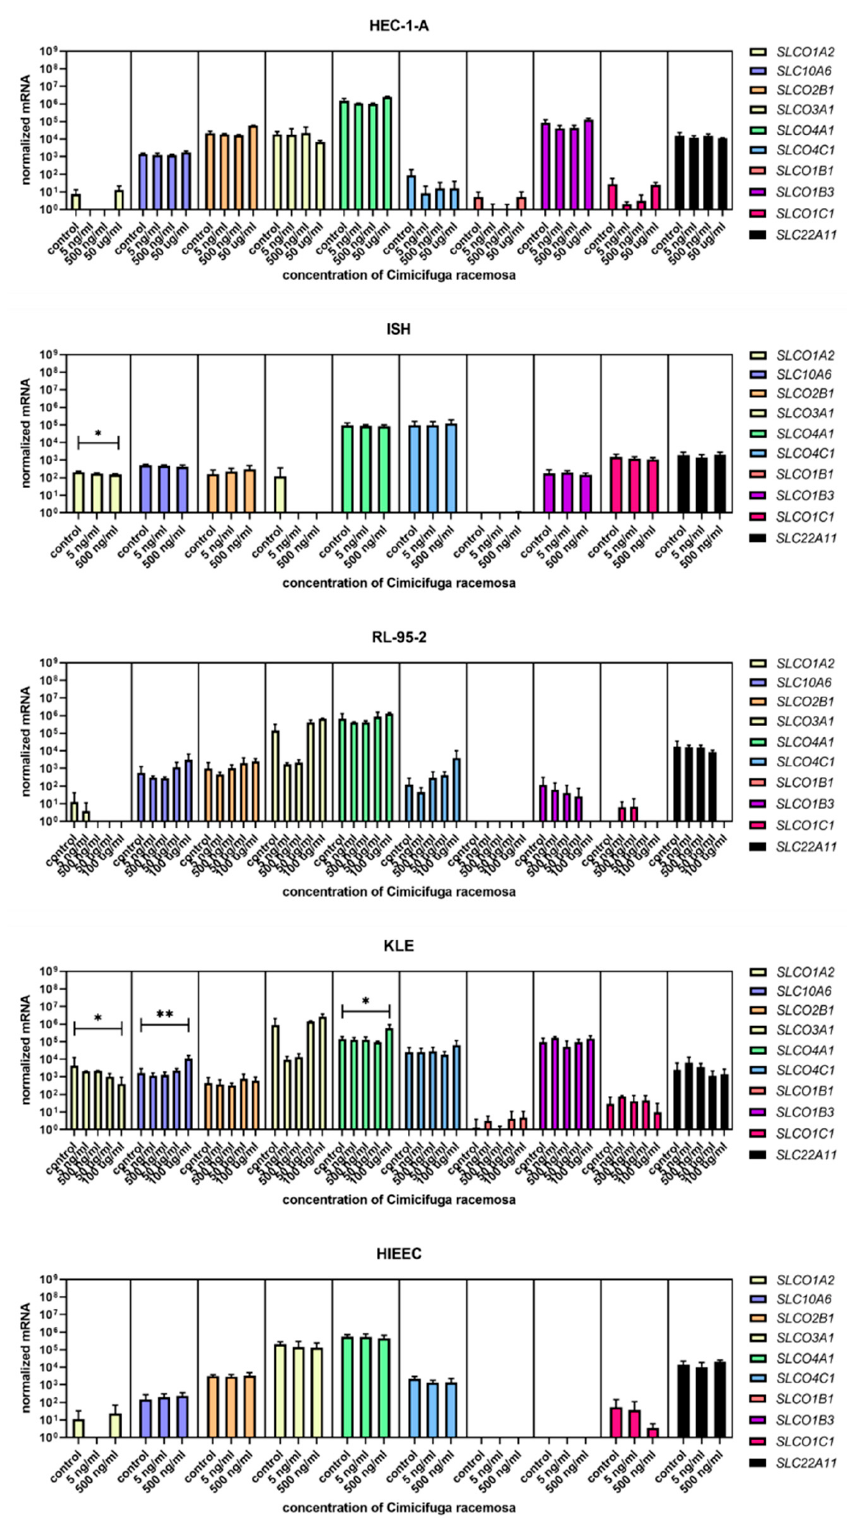
Figure 4. Normalized expression of 10 different genes of uptake ( SLC01A2 , SLC10A6 , SLCO2B1 , SLCO3A1 , SLCO4A1 , SLCO4C1 , SLCO1B1 , SLCO1B3 , SLCO1C1 , SLC22A11 ) in endometrial cancer cell lines HEC-1-A, Ishikawa, RL-95-2, and KLE and control cell line HIEEC. At least three independent experiments were performed. Data are shown as mean ± SD. * p -value ≤ 0.05, ** p -value ≤ 0.01.